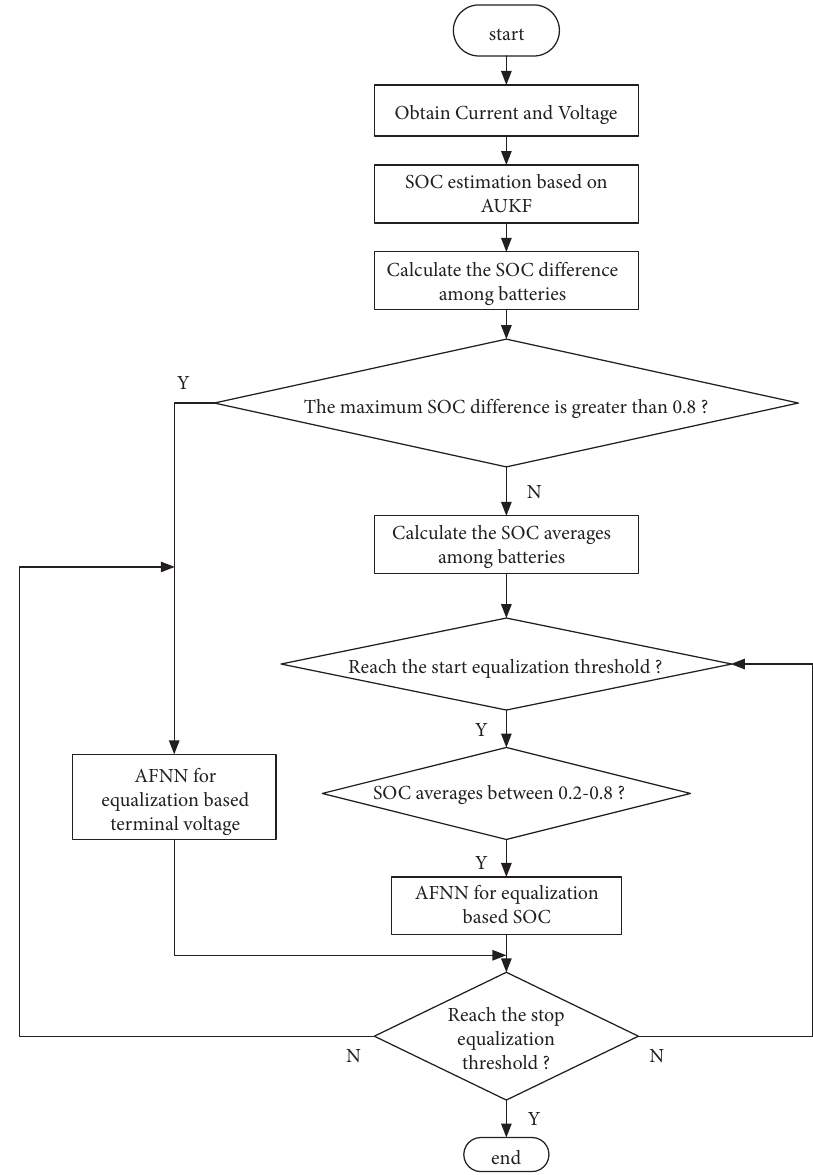
Figure 9: Flow chart of the equalization control